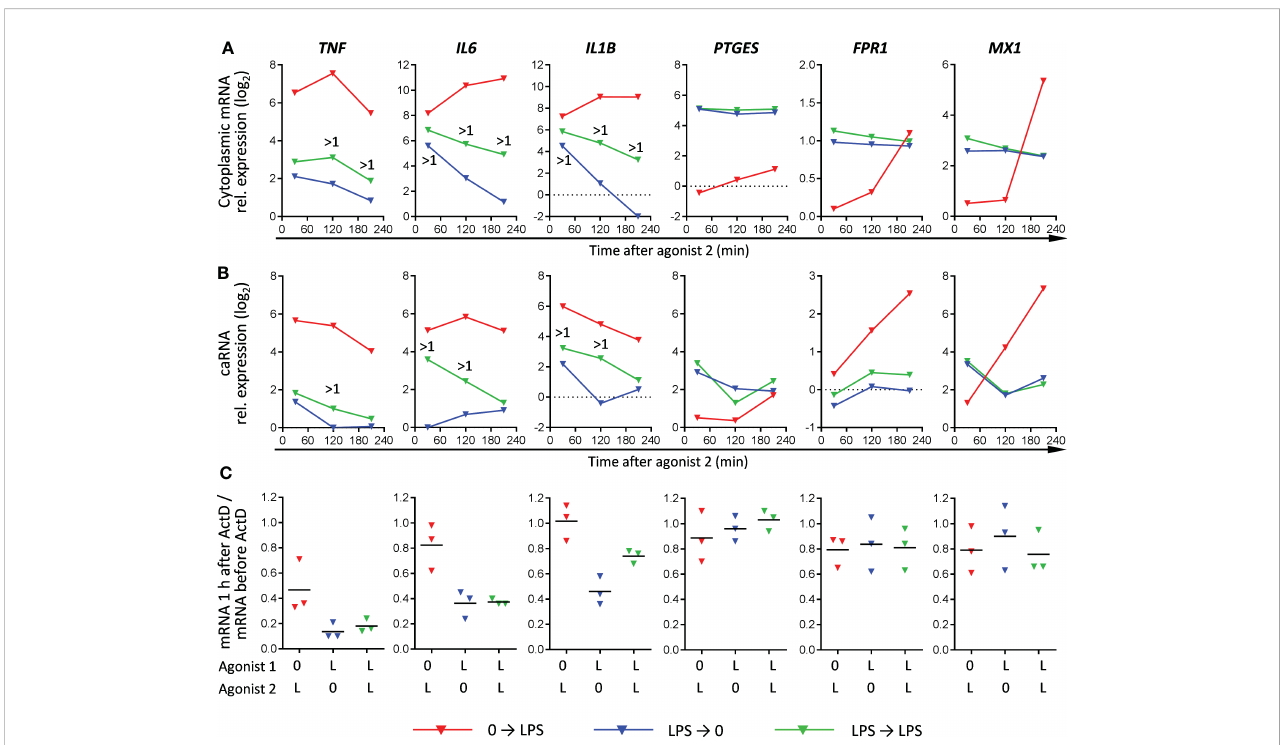
FIGURE 4 Relationship between mRNA expression patterns, mRNA transcription and mRNA stability in naïve and LPS-tolerized macrophages (RT-PCR). Cells were cultured 24 h without or with LPS, washed and recultured without or with LPS for indicated periods of time. (A, B) Kinetics of cytoplasmic mature mRNA expression and chromatin-associated RNA (caRNA) expression, respectively, in naïve and LPS-tolerized macrophages. One experiment out of two with similar results. >1, more than 1 log 2 difference between LPS ➔ 0 and LPS ➔ LPS macrophages. Log 2 mRNA or caRNA expression in untreated macrophages equals zero. (C) stability of mature cytoplasmic mRNA in naïve macrophages stimulated by LPS and in LPS-tolerized macrophages recultured with or without LPS (3 experiments, bars denote means). Actinomycin D (ActD) was added at 1 h of (re)stimulation and cells were further cultured for 1 h. Results are expressed as ratios of mRNA levels after and before addition of